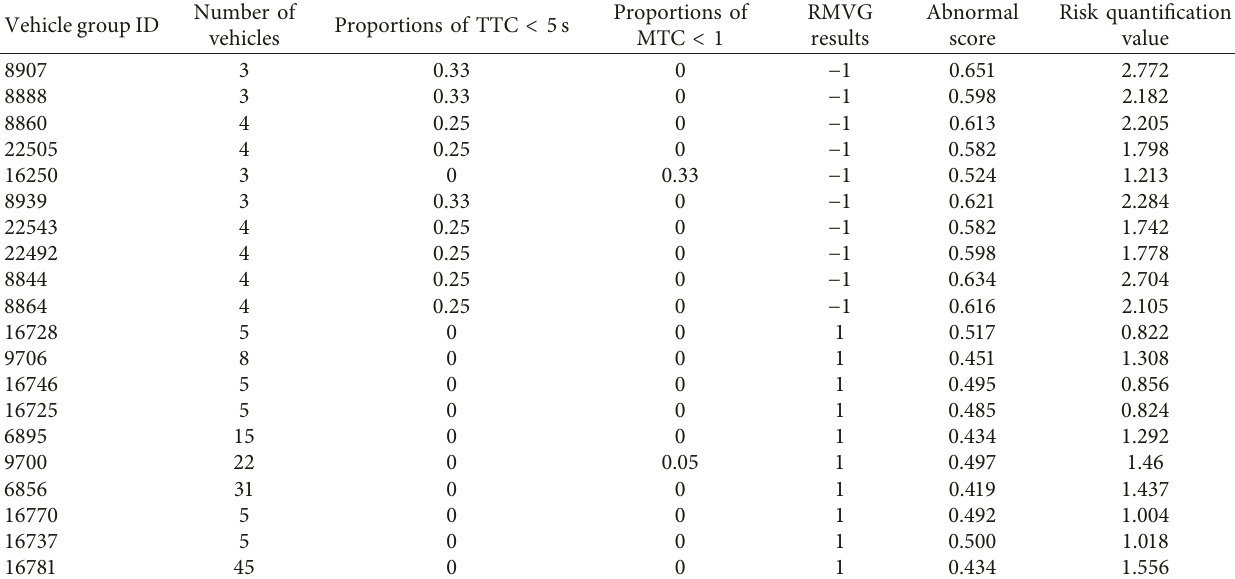
Table 6: RMVG model results.